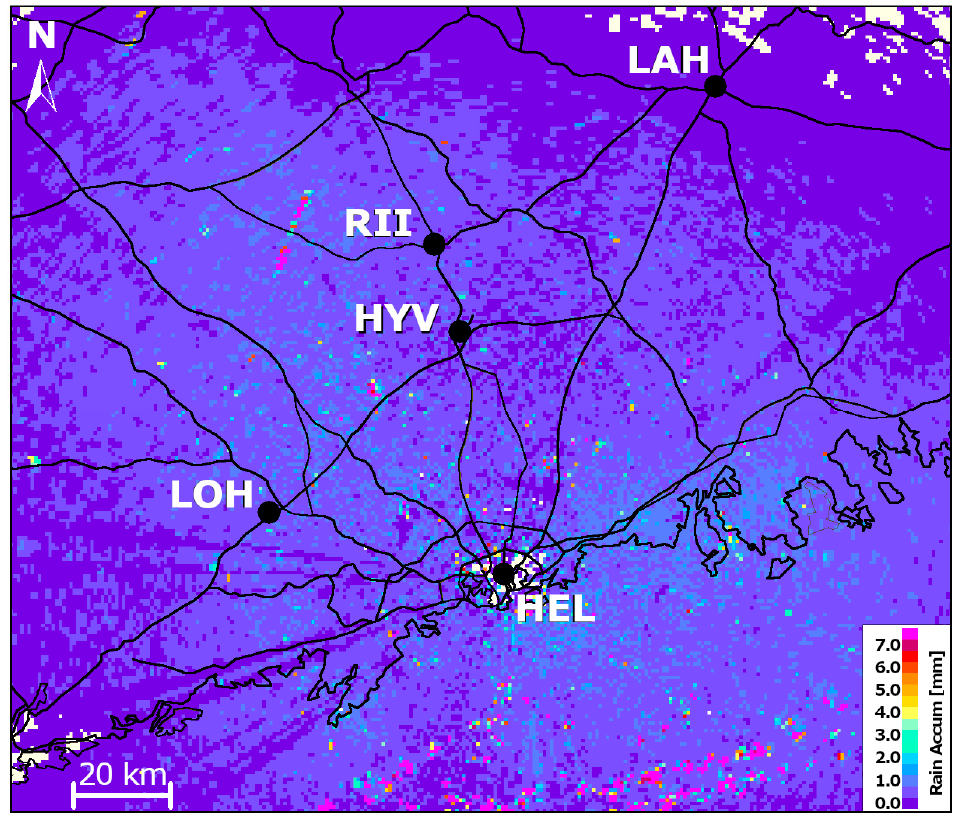
Figure 3. Accumulated reflectivity patterns of bird migration (purple), as observed by the Kumpula weather radar on 9 October 2007, 19:00 UTC and the relevant urban reference points (LOH: Lohja; HEL: Helsinki; HYV: Hyvinkää; RII: Riihimäki; LAH: Lahti).